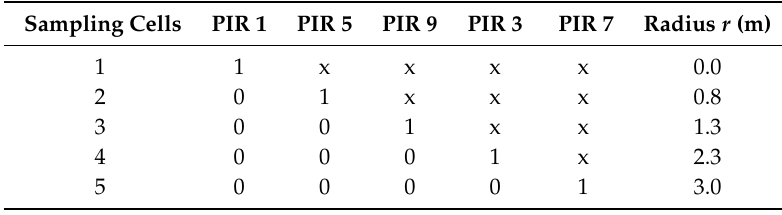
Figure 4. Type II mask: ( a ) radial segmentation; ( b ) multiplexing of five PIRs forms five sampling cells. Table 2. The coding scheme of radius r .